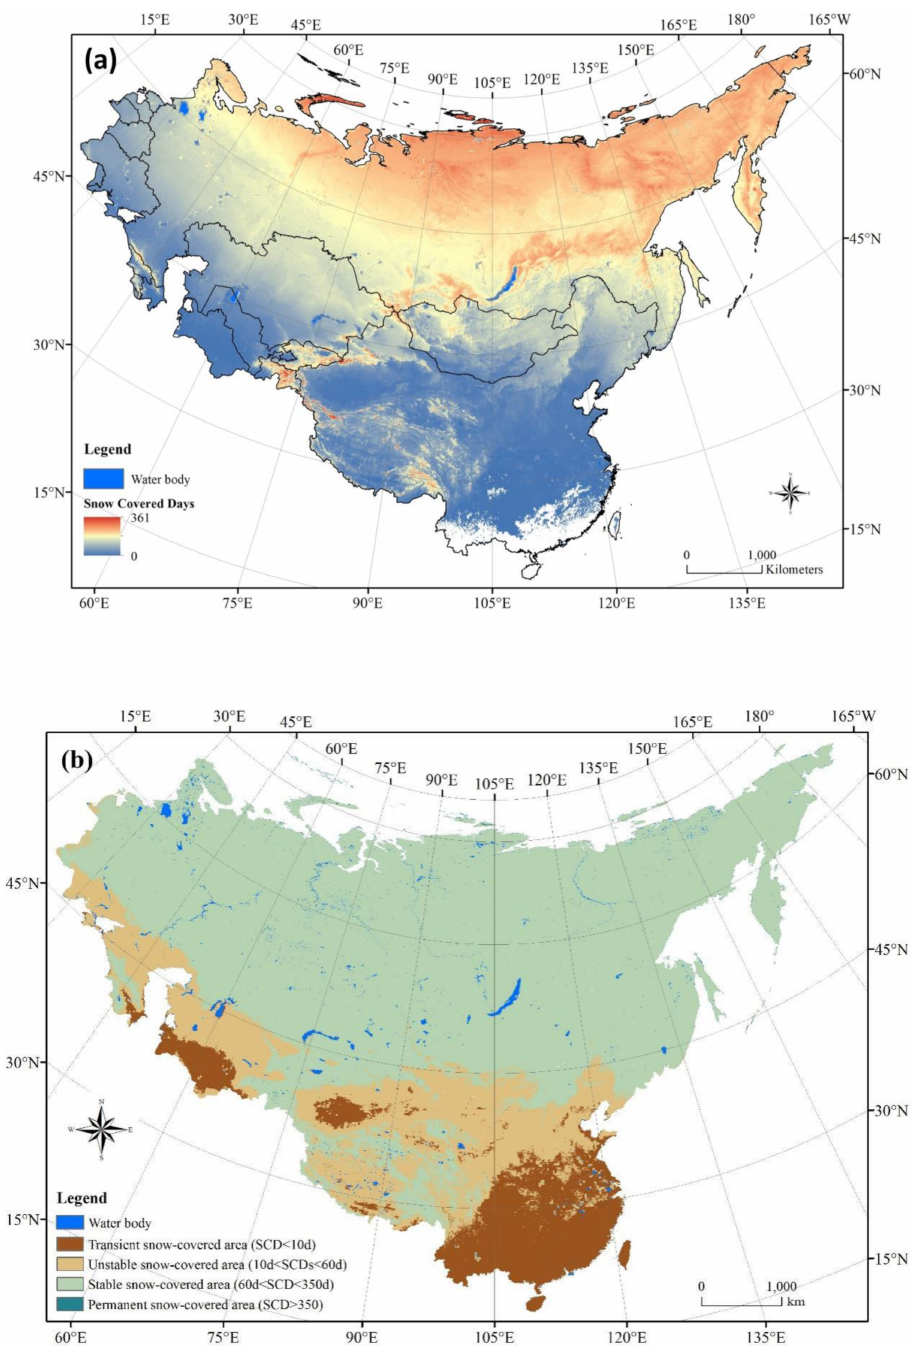
Figure 8. ( a ) The spatial distribution of annual mean snow-covered days (SCDs) in the study area from 2000 to 2016, and ( b ) reclassification of SCDs based on snow cover